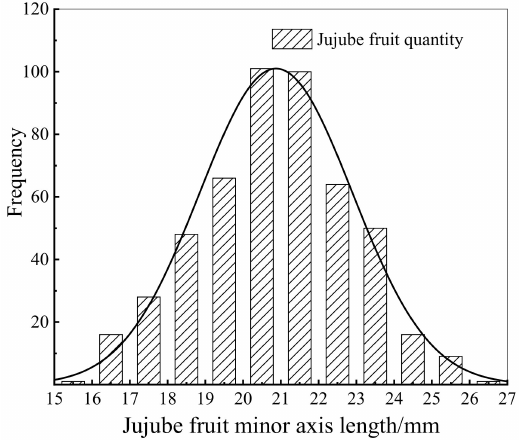
Figure 4. The minor axis size distribution of 500 jujube fruit.